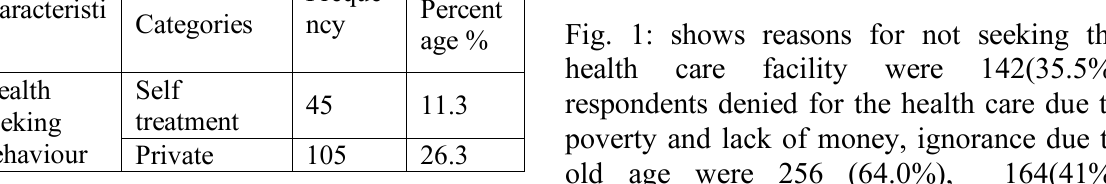
Fig. 1: shows reasons for not seeking